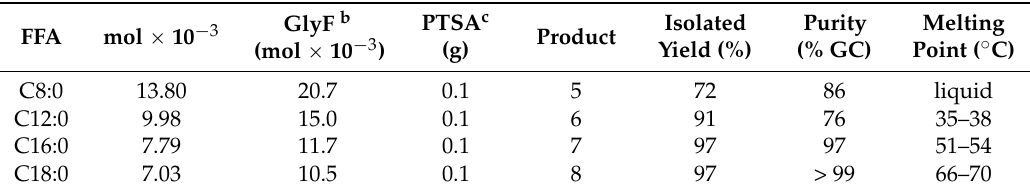
Table 2. Reaction between glycerol formal and the FFAs a